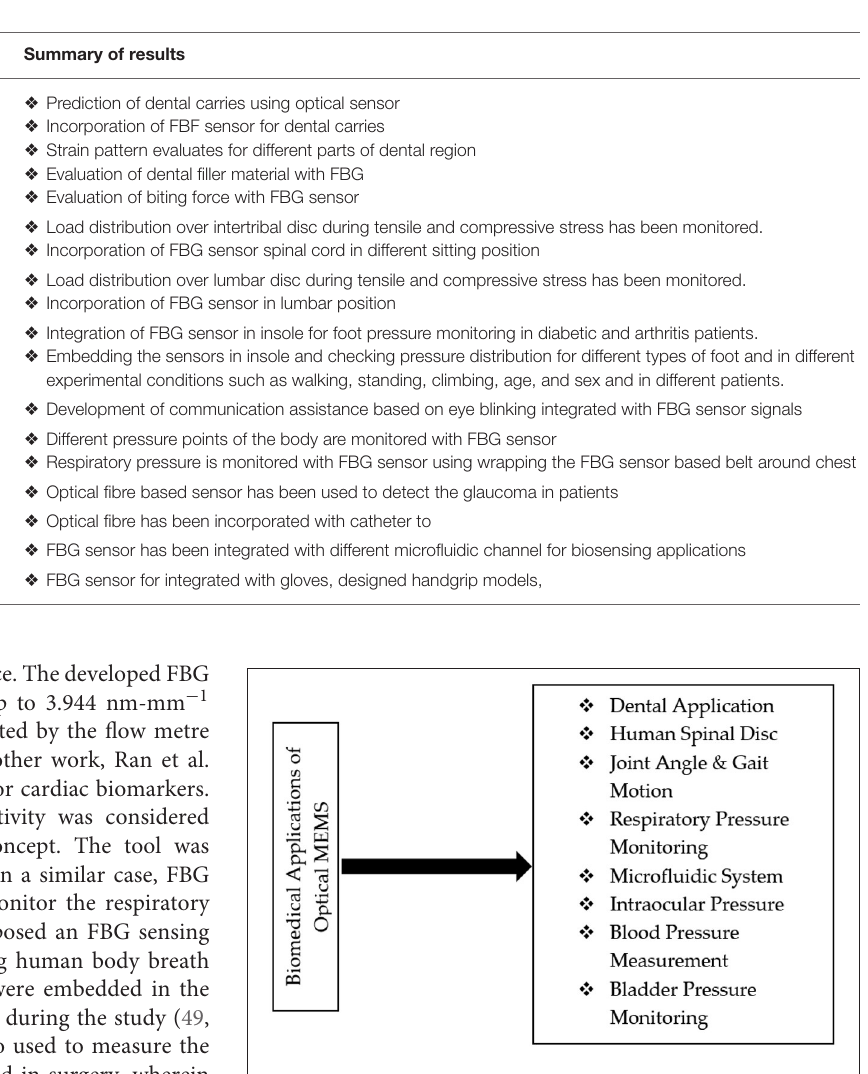
FIGURE 12 | Major applications of optical MEMS in